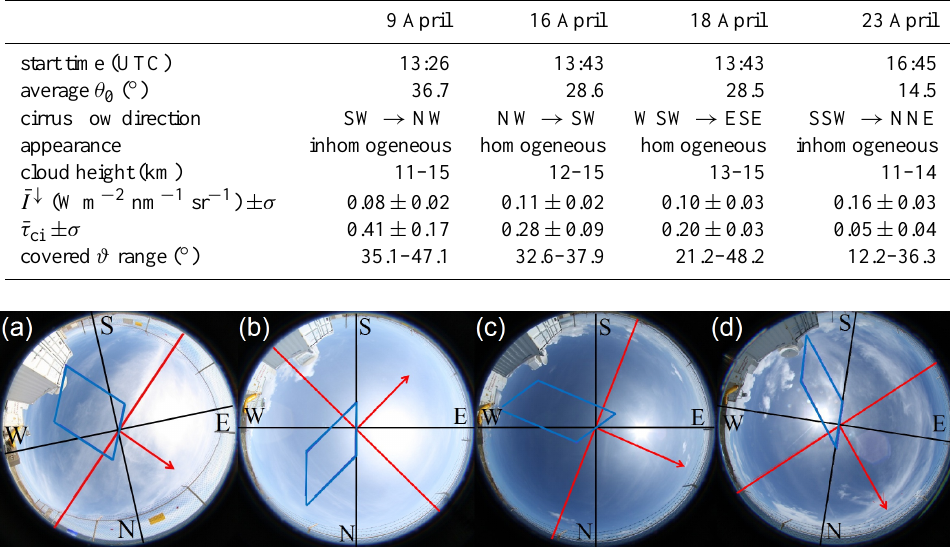
Fig. 7. All-sky images from the beginning of the evaluated AisaEAGLE radiance measurements for (a) 9 April, (b) 16 April, (c) 18 April and Fig. 7: All-sky image from the beginning of the evaluated AisaEAGLE radiance measurements, flow direction of the cirrus (d) 23 April 2011 with the flow direction of the cirrus (red arrow) and FOV of the AisaEAGLE radiance measurements (blue). Orientation (red arrow) and FOV of the AisaEAGLE radiance measurements (blue). Orientation given by black lines and capital letters. given by black lines and capital